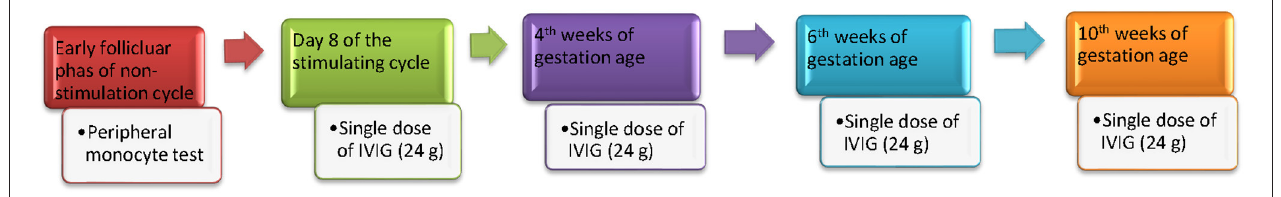
FIGURE 1 | The timing and protocol of IVIG treatment. Peripheral monocyte test was performed on the 2–3rd day of the menstrual cycle prior to ovarian hyperstimulation. Women received the first dose of IVIG (24g TBSF human immunoglobulin; CSL Limited, Broadmeadous, Australia) on day 8 of the stimulating cycle. If a viable pregnancy was confirmed by serum hCG concentrations and ultrasound, IVIG was continued in 4, 6, and 10th weeks of gestation age (a total dose of 96g) according to the published